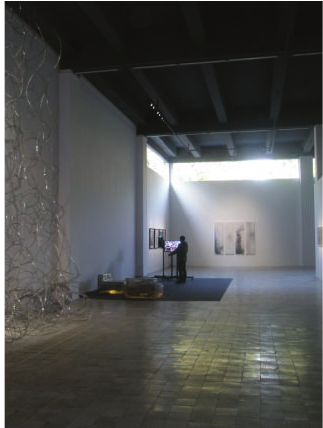
Figure 16: An exhibition